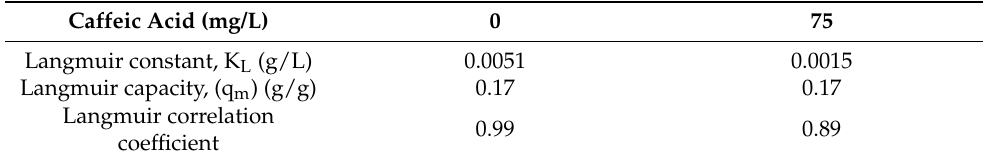
Table 4. Effect of caffeic acid on protein adsorption from a model wine solution. Protein concentration was monitored by using the Bradford protein assay and UV-Vis spectrometry at 595 nm. Caffeic Acid